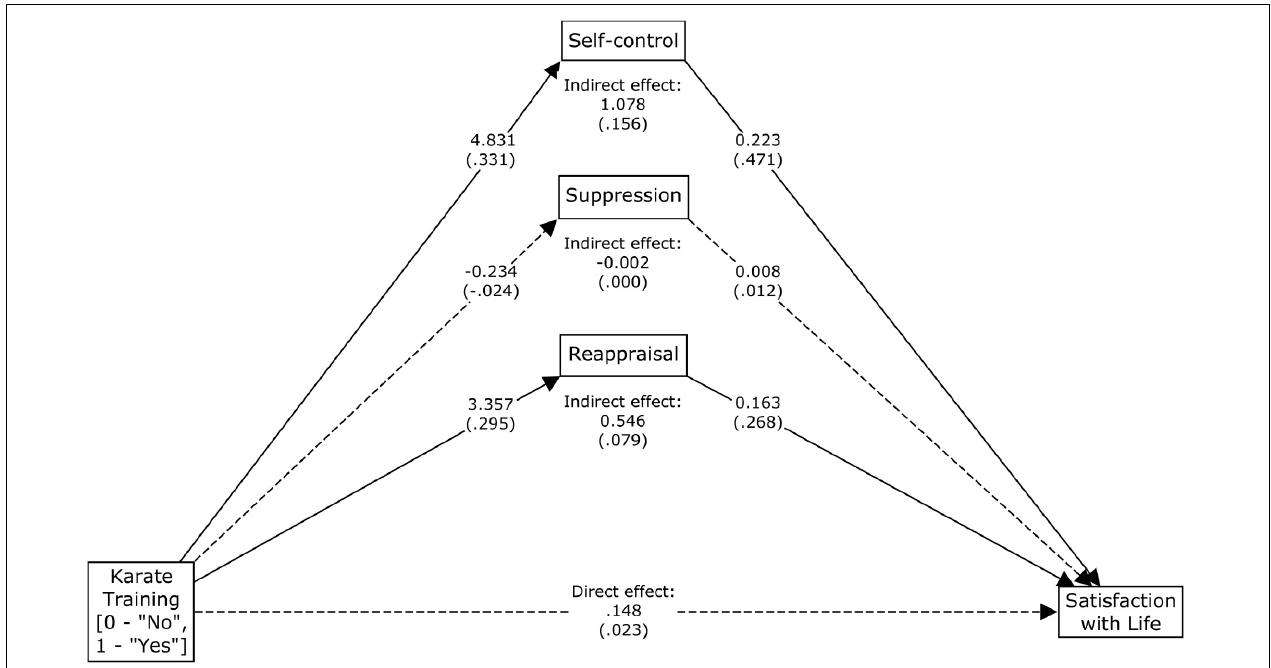
FIGURE 1 | Diagram presenting raw and standardized (in brackets) parameter estimates obtained in the linear regression-based mediation analysis of indirect, direct and total effects of karate training on satisfaction with life with self-control, suppression, and reappraisal as mediating variables, and with gender and dichotomized age as covariates. Solid lines–significant effect; dashed lines–insignificant effect. Parameter estimates were tested for significance using bias-corrected bootstrap confidence intervals. Effects of gender and dichotomized age were estimated in mediation analysis but are not